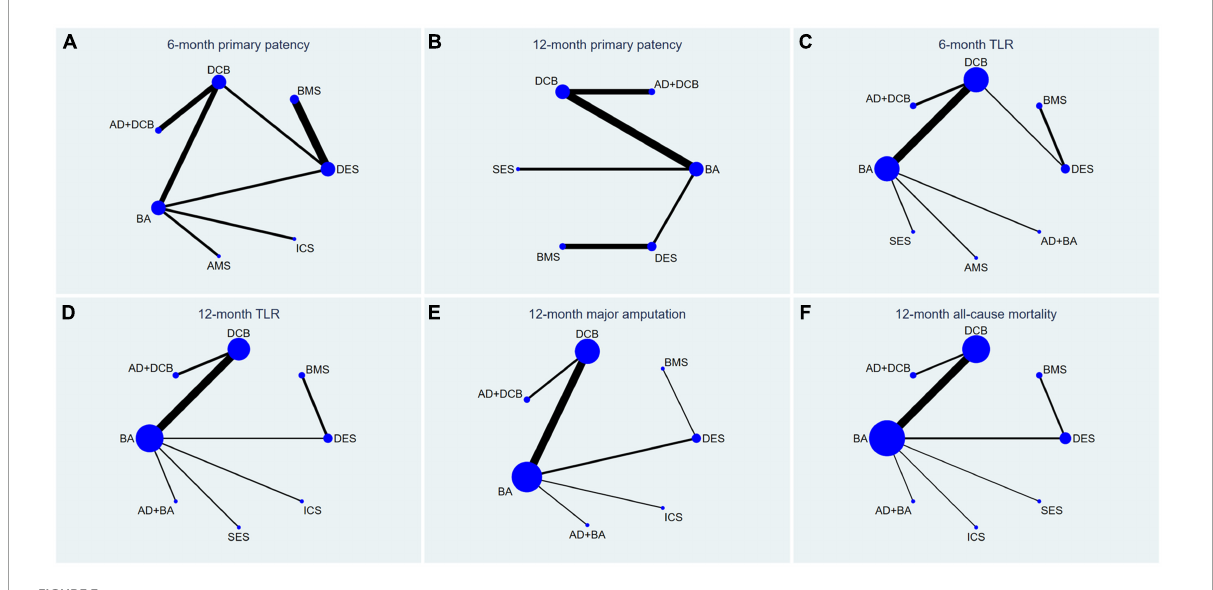
FIGURE3 Network plots for all outcome measures. The size of the node was proportional to the sample size and the width of the line was proportional to the number of related studies. TLR, target lesion revascularization; BA, balloon angioplasty; DCB, drug-coated balloon; AD, atherectomy device; DES, drug-eluting stent; BMS, balloon-expandable bare metal stent; SES, self-expanding stent; AMS, absorbable metal stents; ICS, inorganics-coated stent. The first row is (A–C) , and the second row is (D–F) .